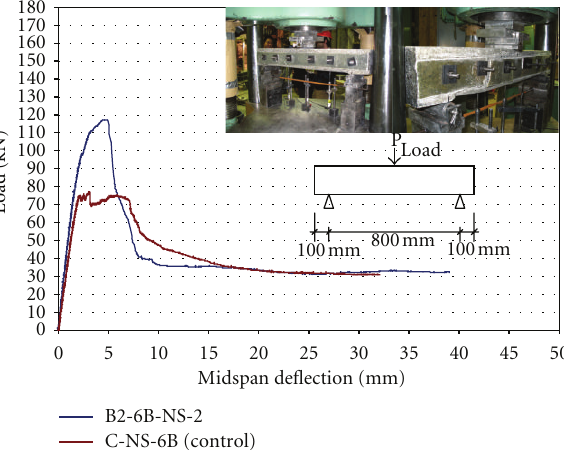
Figure 30: Load versus midspan deflection of RC beam B2-6B-NS- 1.